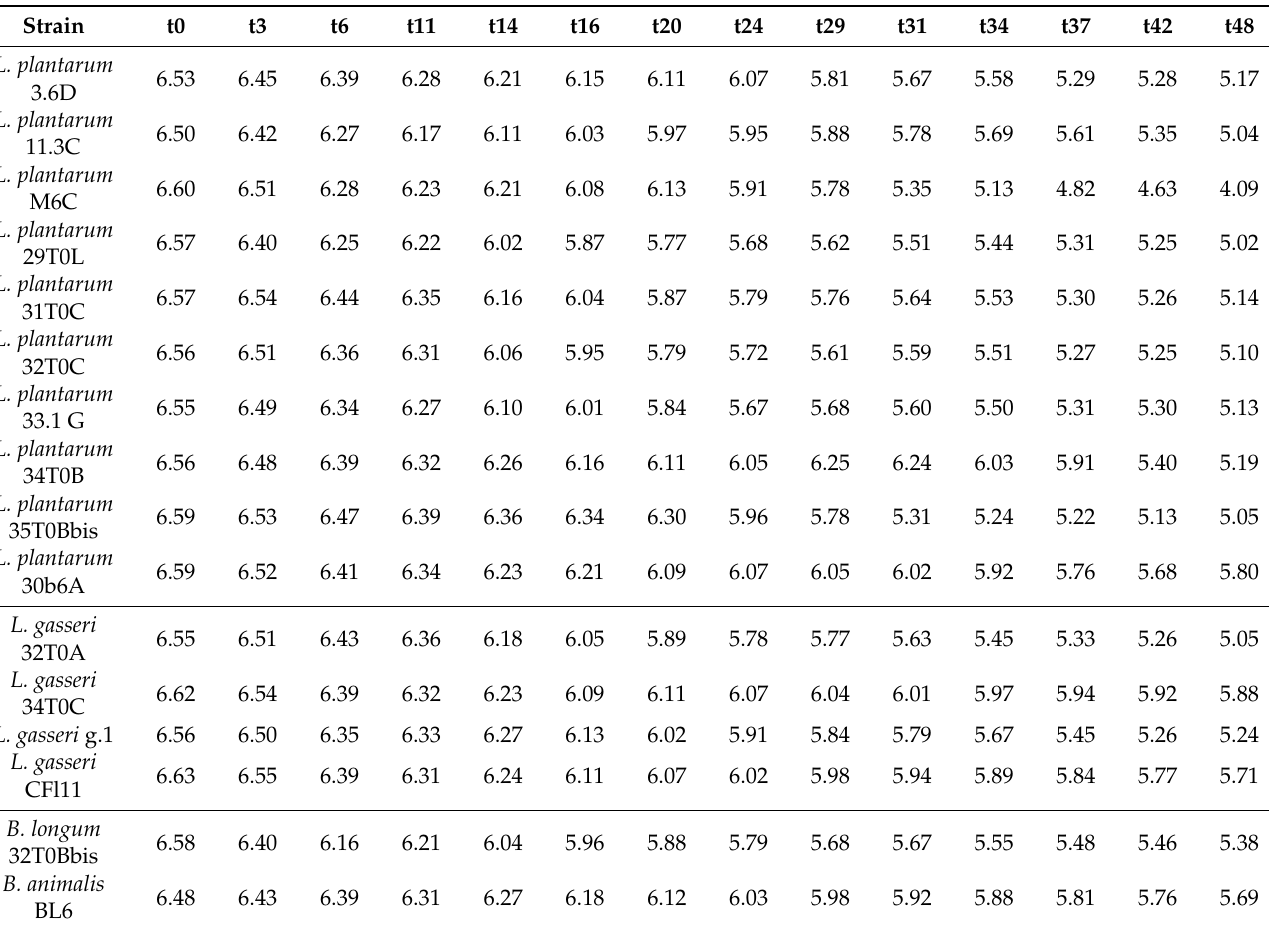
Table 6. Kinetics of acidifications (reported as changes of pH values) of lactobacilli and bifidobacteria inoculated in pasteurized whole milk. The sampling points are expressed as hours. The pH values are the average of three replicates with a variability <5%.